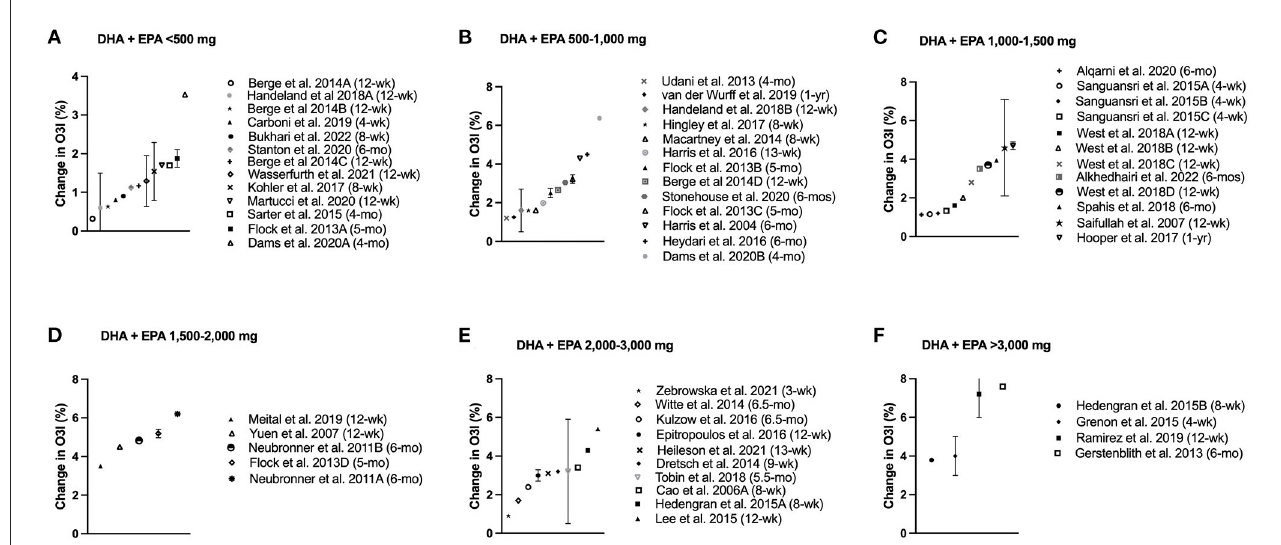
FIGURE2 Change in omega-3 index (O3i) from baseline for protocols using combined EPA + DHA separated by dose. Data are presented as means ± SD (if available in publication). Legend shows length of supplementation/fortification in parentheses. (A) Doses less than 500 mg/d; (B) Doses ranging from